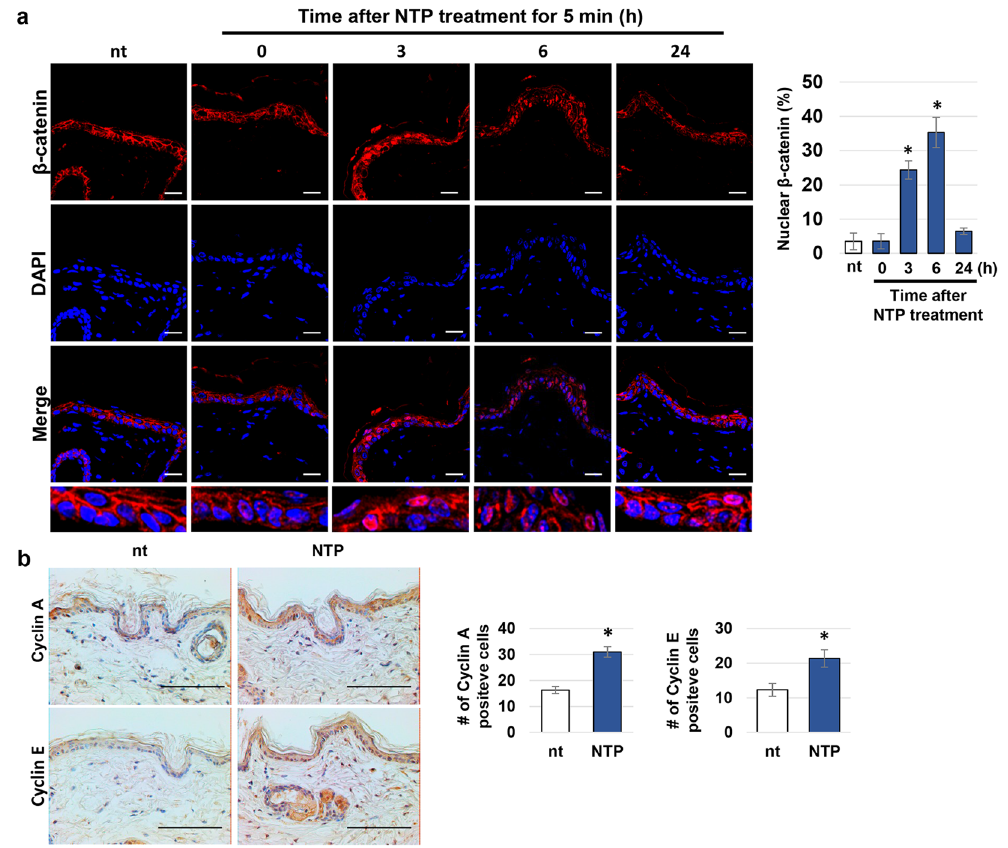
Figure 5. The effect of NTP on β -catenin activity in skin tissue. ( a ) Marked regions on the dorsal skin of four HRM2 mice were subjected to NTP treatment for 5 minutes at the indicated time point (0, 3, 6, and 24 hours) before sacrificing the mice. (Left panel) The skin tissue was isolated and subjected to immunofluorescence staining of β -catenin (red), DAPI counterstaining of the nuclei (blue), and confocal imaging. Scale bar: 20 μ m. (Right panel) The graph showing the percent of nuclear β -catenin positive cells in epidermal tissues, * p < 0.001. ( b ) Non-treated and NTP-treated skin tissue was isolated 24 hours after treatment and subjected to immunohistochemistry against cyclin A and E. The nuclei were counterstained using hematoxylin. Scale bar: 100 μ m. The number of Cyclin A and Cyclin E-positive cells were counted and represented as graphs (Right panels). Data shown are representative of three independent experiments, * p <